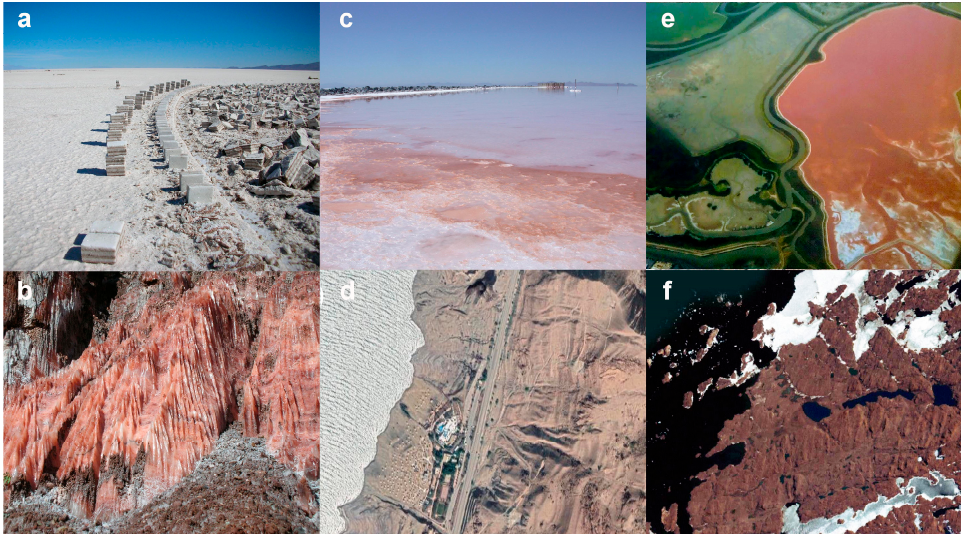
Figure 1. Isolates were obtained from halite deposits from two locations in Bolivia and brine from the Great Salt Lake and Dead Sea. ( a ) Salar de Uyuni in Potosí, Bolivia; ( b ) Sal Rosada (pink salt), Tarija, O’Connor Province, Bolivia; ( c ) Great Salt Lake, North Arm; ( d ) Dead Sea, Jordan; ( e ) Aerial photo of a crystallizer pond from a San Francisco Bay Solar Saltern, California, U.S.A., reproduced with permission from Satyajit DasSarma; ( f ) Deep Lake (rhombus-shaped lake in image), Antarctica. Panels d and f were reproduced with permission from Find Latitude and Longitude, https://www.findlatitudeandlongitude.com (accessed on 13 April 2022).